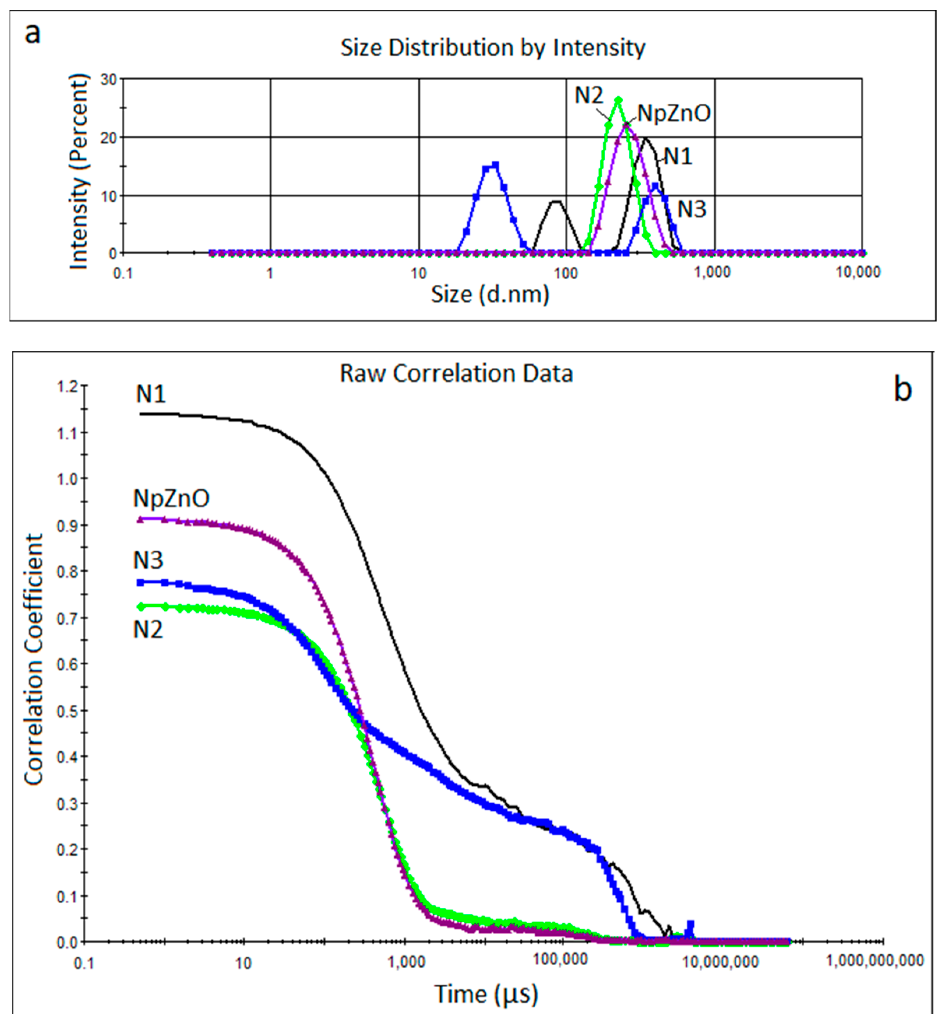
Figure 1. ( a ) Size distribution by intensity and ( b ) correlation coefficient for unmodified ZnO dispersion and for modified ZnO dispersions: N1 (ZnO-TEOS/OTES), N2 (ZnO-TEOS/GPTMS), N3 (ZnO-TEOS/ODTES).